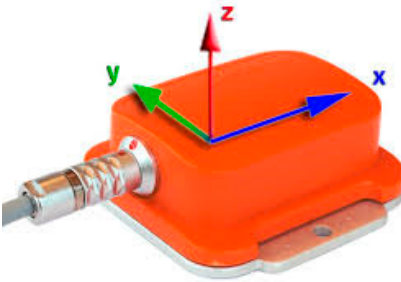
Figure 1. Xsens MTx 3-DOF (degrees of freedom) orientation tracker (photo from [14]).